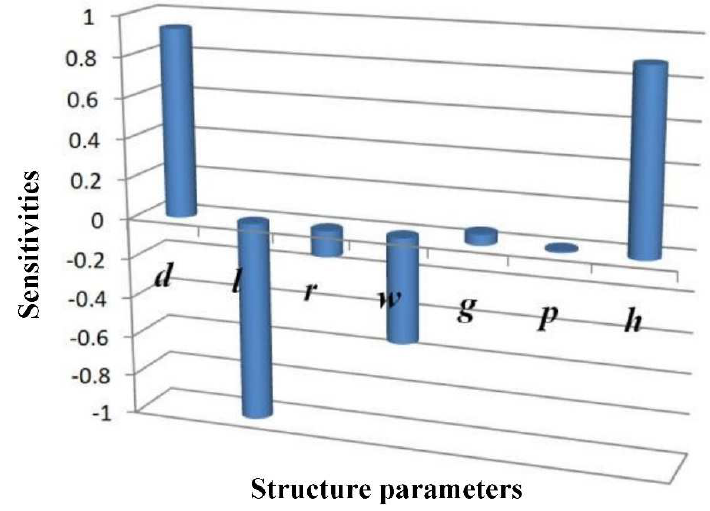
Figure 7. Structural parameter sensitivity.